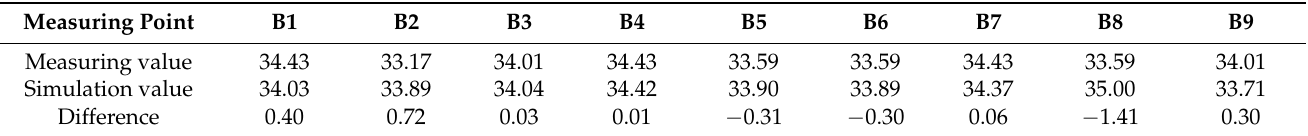
Table 2. Comparison between measurement and simulation values of temperatures at 14:00, 15 August (°C).